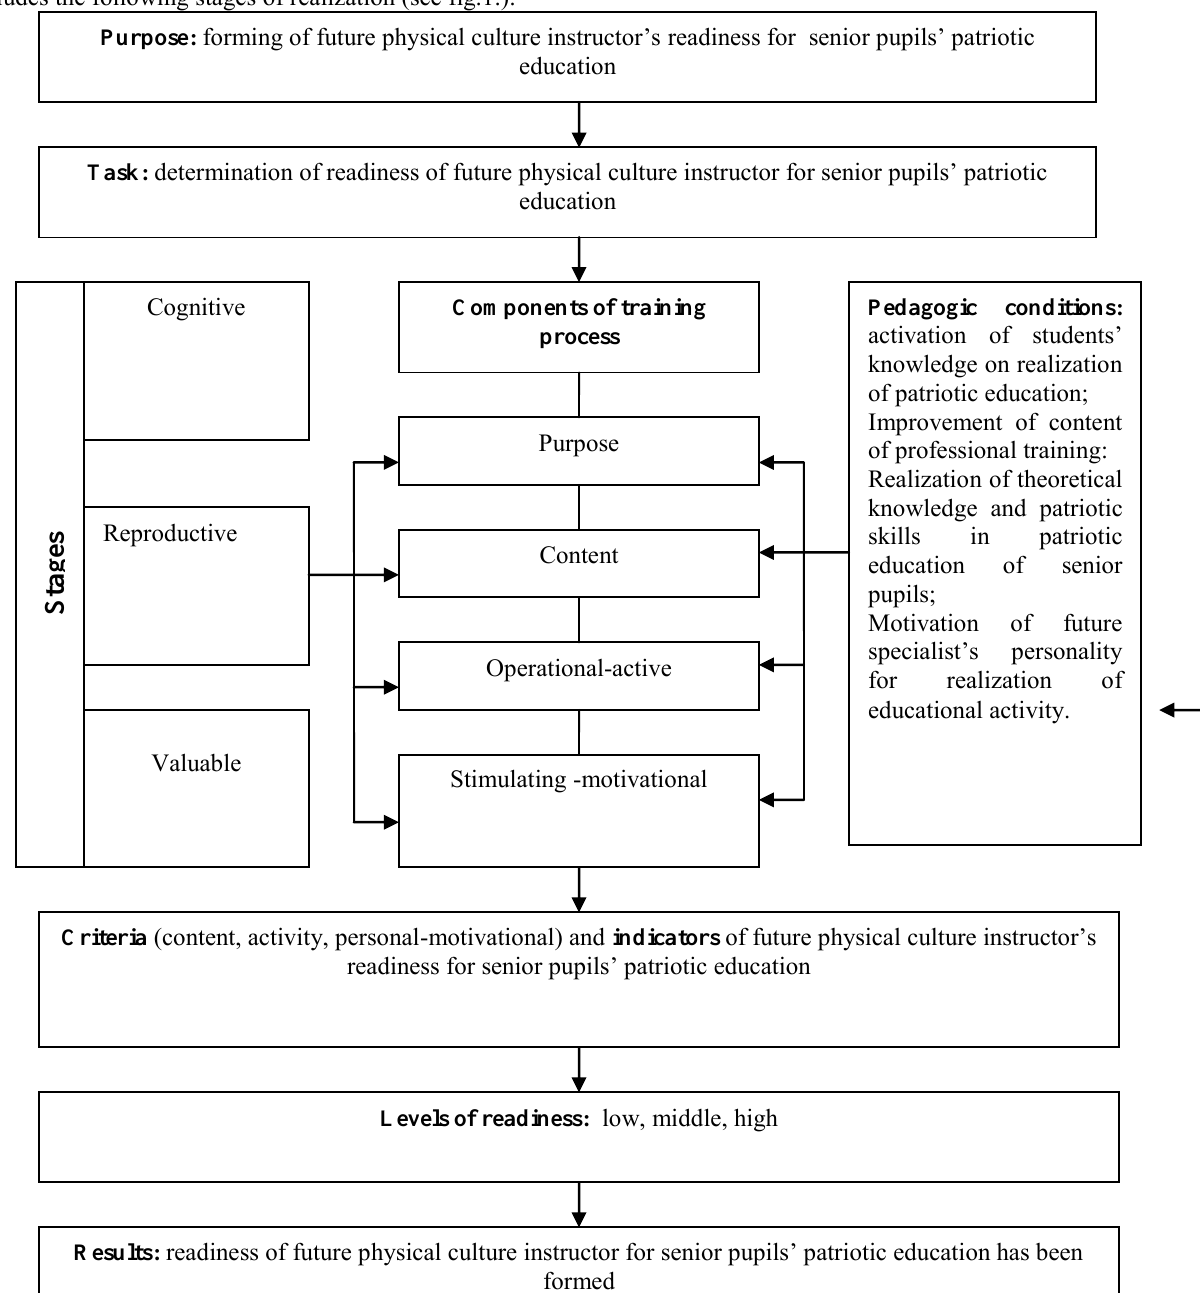
Fig.1 Model of forming of future physical culture instructor’s readiness for senior pupils’ patriotic